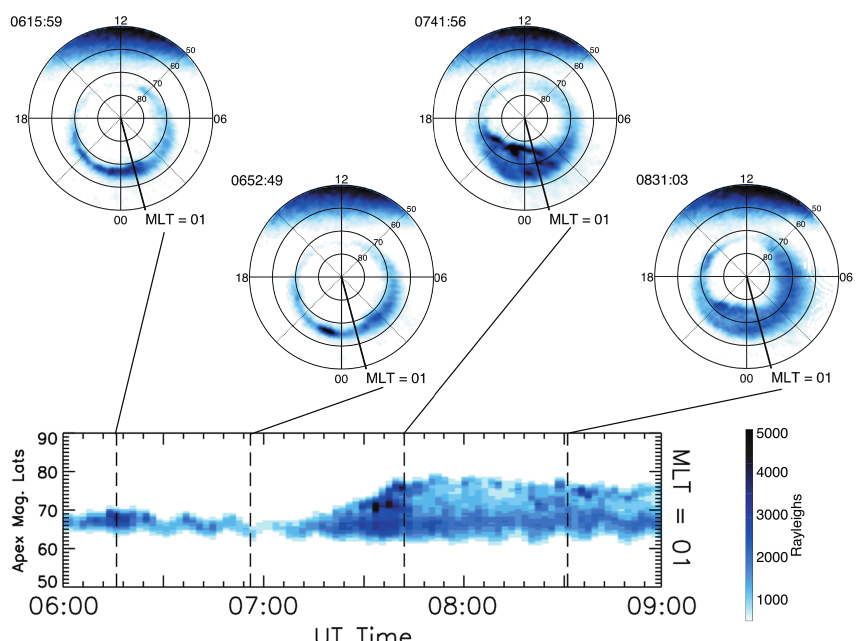
Fig. 1. An example of how a keogram is made using data from the isolated substorm on 4 January 2001. Top shows images from IMAGE FUV WIC in apex magnetic latitude with noon at the top and midnight at the bottom. To make a keogram a slice is taken (01:00 MLT) and then plotted vs. universal time. The color show the intensity of the aurora in Raylieghs.